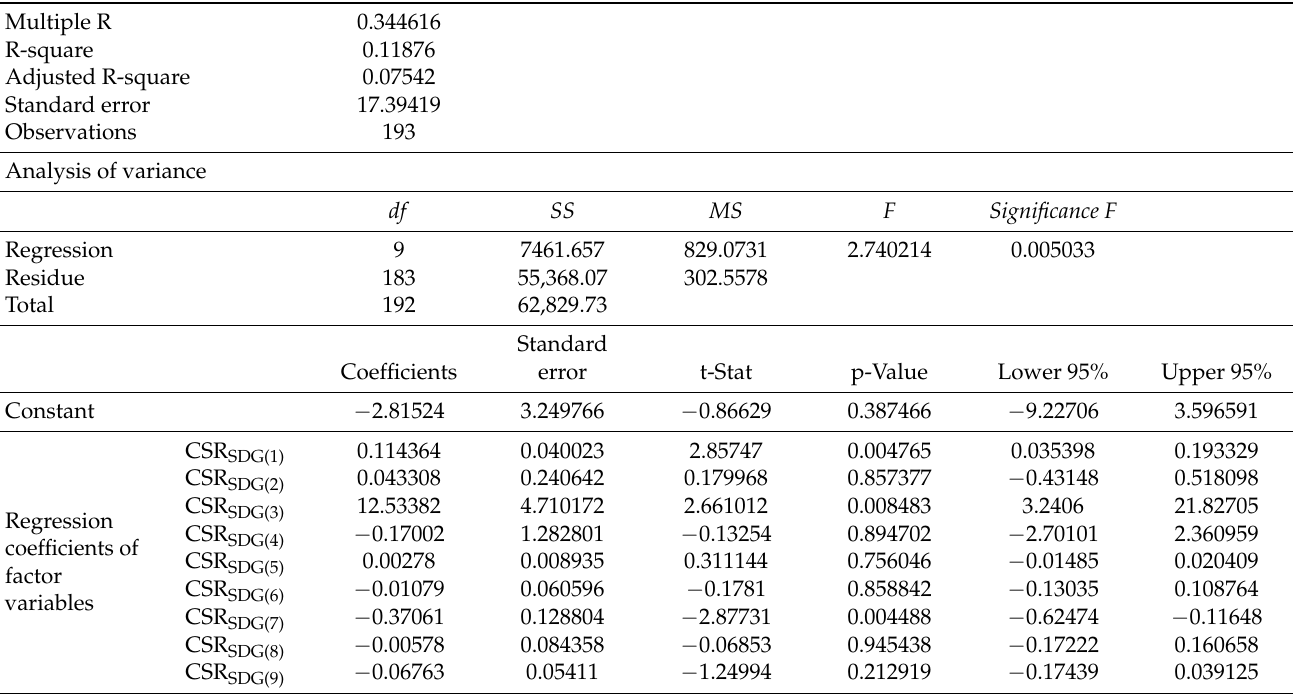
Table 13. Regression statistics for all factor